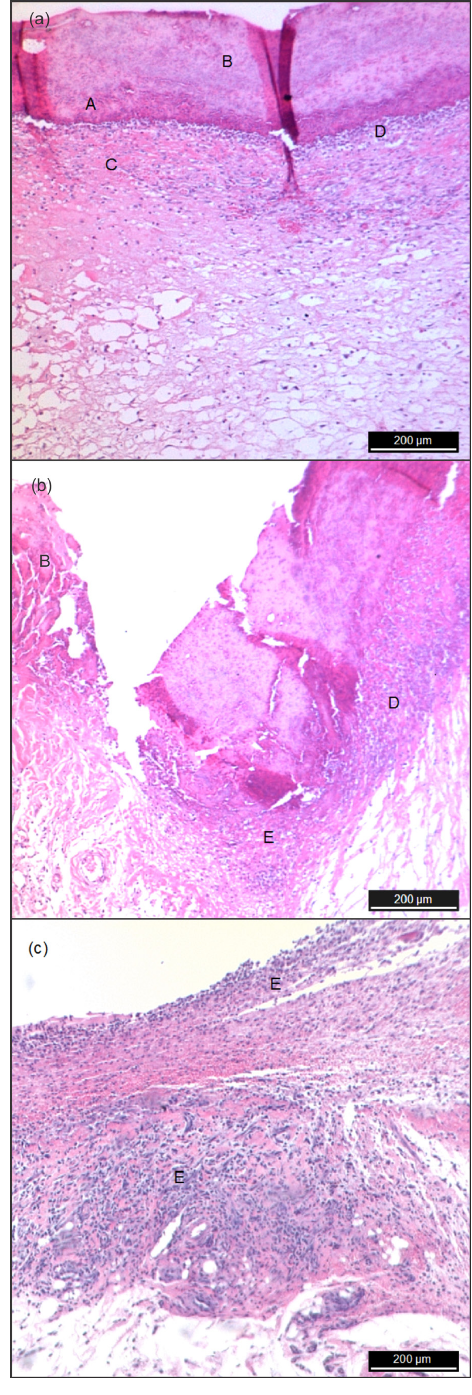
Figure 6. 3-day period, (a) – GI shows early neovascularization, crust and disorganized granulation tissue and moderate inflammatory reaction in the epithelial healing process; (b) – GII shows absence of epithelium, crust and disorganized granulation tissue and mild inflammatory reaction; (c) – GIII shows absence of epithelium, disorganized granulation tissue and mild inflammatory reaction. Inflammatory infiltrates were predominantly composed of polymorphonuclear cells, such as macrophages and neutrophils. Epithelium (A), crust (B), neovascularization (C), inflammatory infiltrate (D) and granulation tissue (E). Staining: